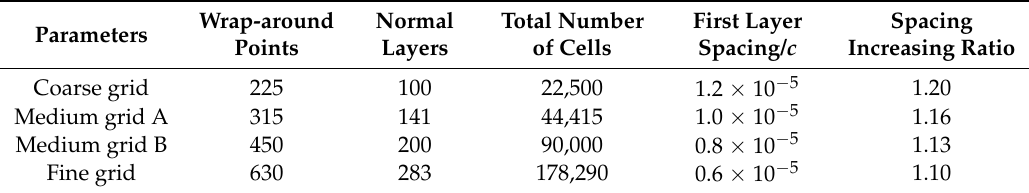
Table 1. Details of the grids employed for the DU97-Flatback airfoil.